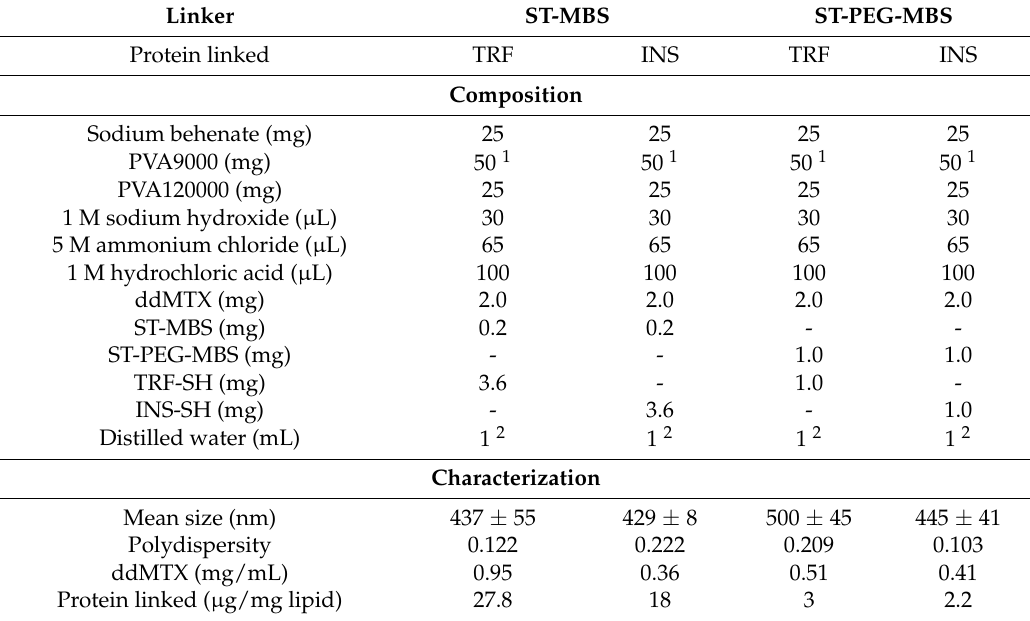
Table 2. Composition and characterization of the functionalized ddMTX-loaded behenic acid SLNs. Linker ST-MBS